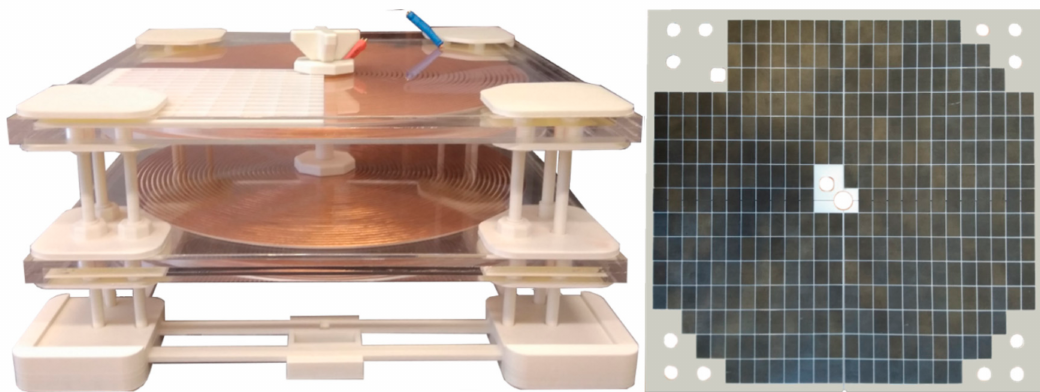
Figure 4. System of coupling coils with adjustable transfer distance ( left ) and reconfigurable magnetic shielding ( right ).